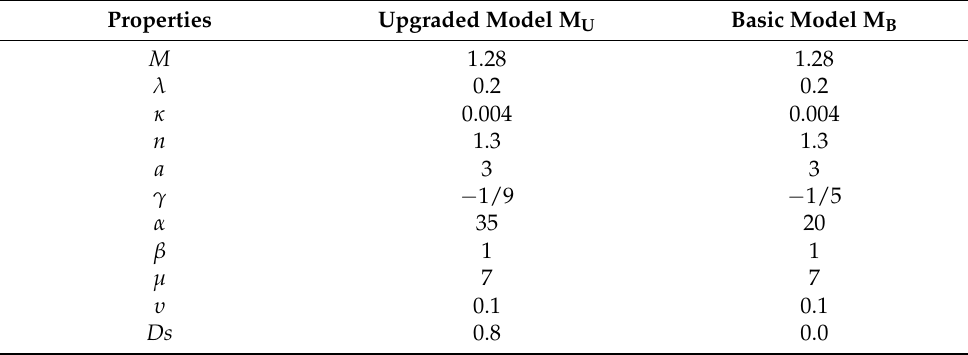
Table A1. Parameters adopted for Model Validation in Figures